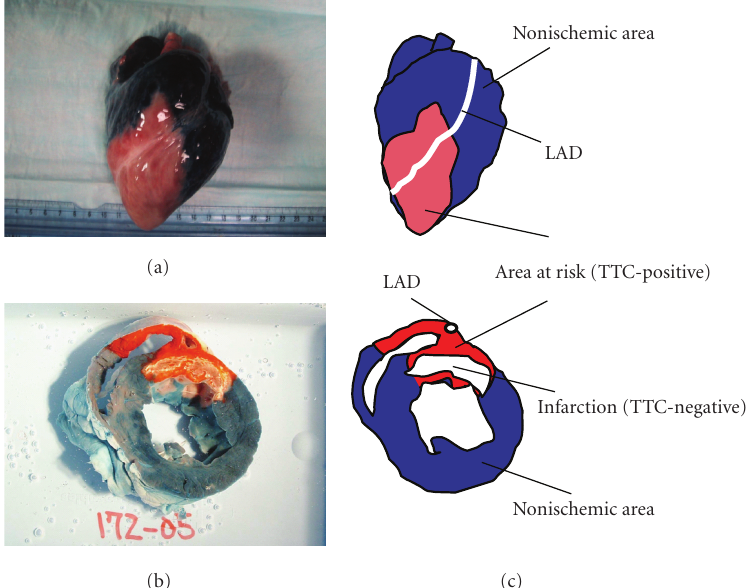
Figure 3: This picture demonstrates the porcine heart (a) and cross-sectional slice (b). The dark area stained with Evans Blue indicates nonischemic territory, and the red area stained with TTC is the area at risk for ischemia (TTC-positive). In (b), the white area is the infarcted (necrotic) myocardium (TTC-negative). The schema explains what the stained colors and territories indicate (c). LAD: left anterior descending artery. Adapted from